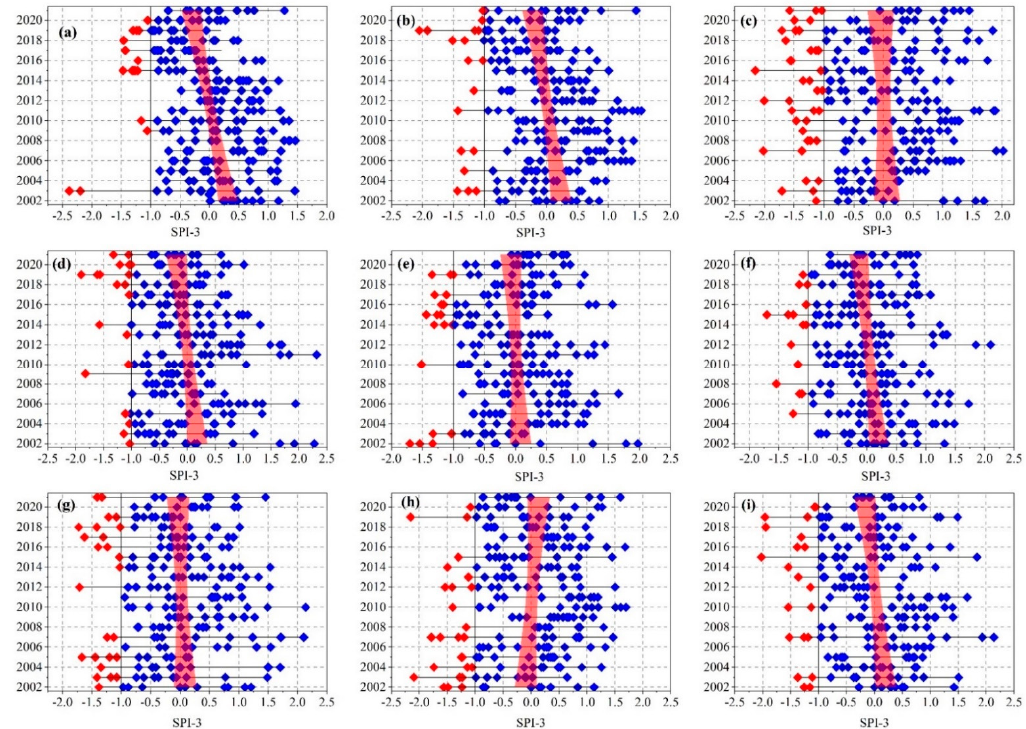
Figure 5. SPI-3 values on a monthly scale across South African provinces between 2002 and 2021: ( a ) WES-C; ( b ) NR-C; ( c ) FS; ( d ) ES-C; ( e ) KZN; ( f ) MP; ( g ) LPP; ( h ) GG; ( i ) NW (red dots indicate SPI-3 values of less than –1).